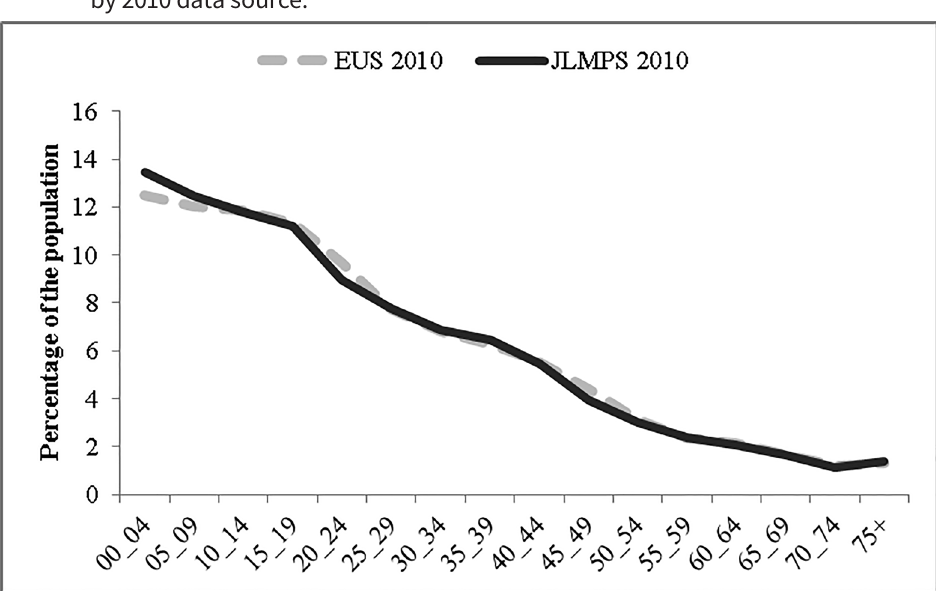
Comparison of population structure (percentage in 5-year age group), Jordanians, by 2010 data